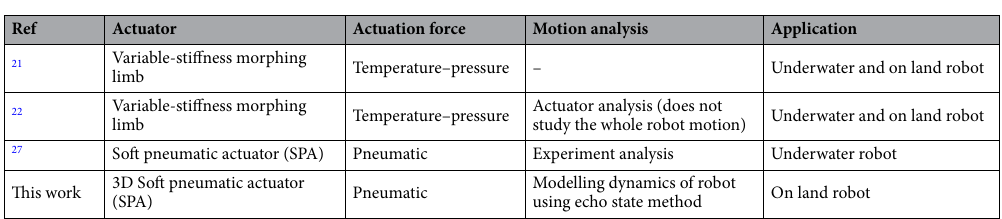
Table 2. Summary of the Soft actuated turtle robots mentioned in this